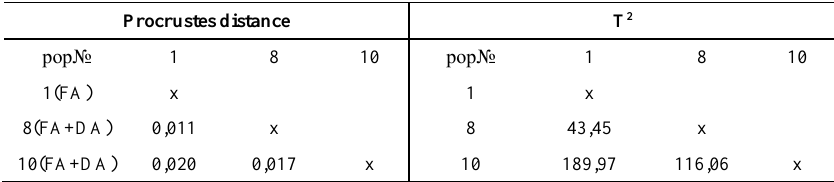
Discrimination in geographical context did not show the strong clustering according to spatial